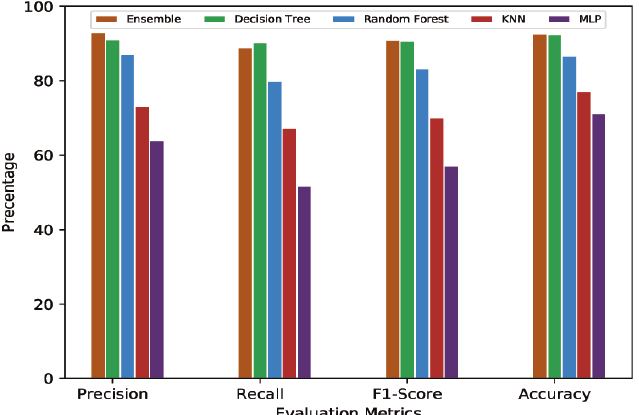
Figure 4. Graphical representation of comparative analysis of ML/DL approaches (prediction validity = 10 min, threshold = 60%).